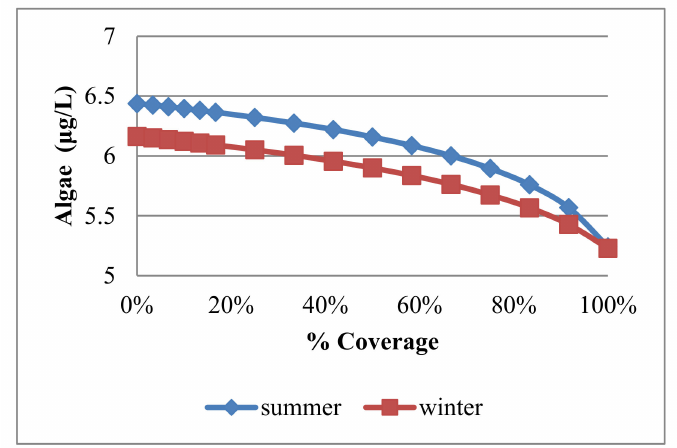
Figure 9. Algae concentration at the canal end in the winter and summer versus percentage coverage for the 50-km length of the